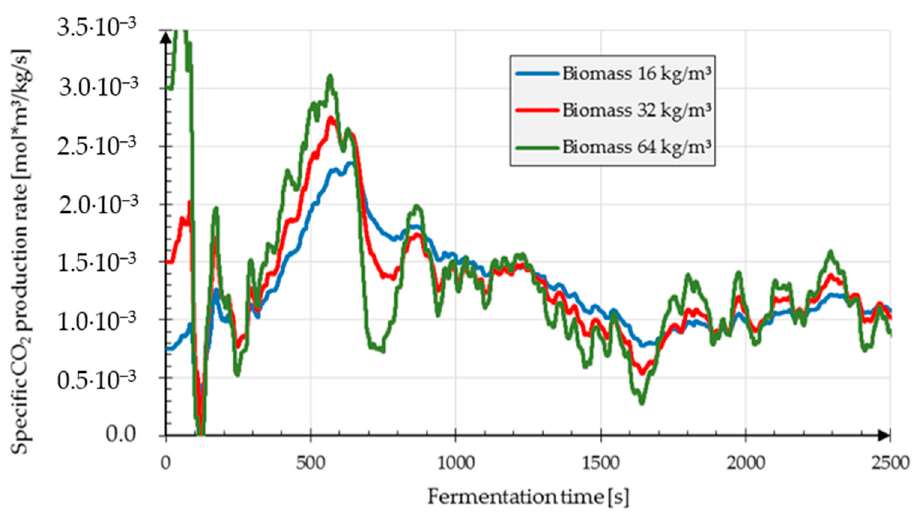
Figure 7. Estimated specific CO 2 production rate calculated during three runs of the extended Kalman filter with the same measurements but with different assumed yeast concentrations; the production rate was multiplied by 2 where the yeast concentration was considered to be 64 kg/m³; the production rate was divided by 2 where the yeast concentration was considered to be 16 kg/m³; the correct yeast concentration was 16 kg/m³.